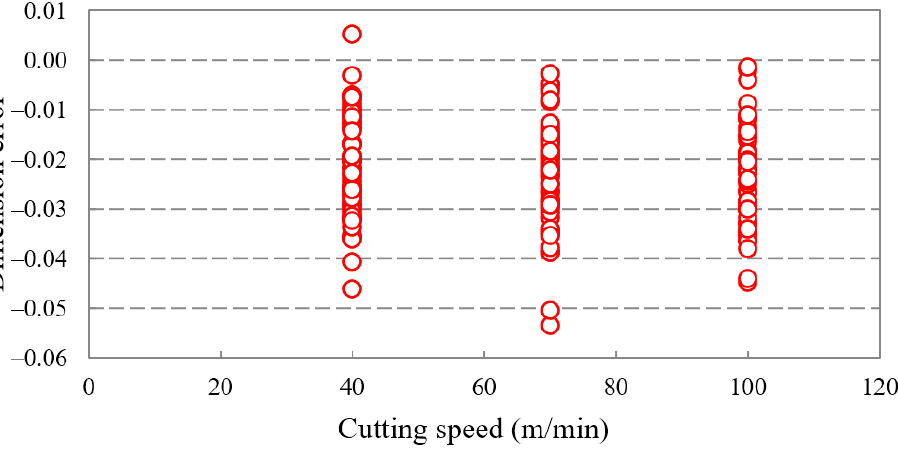
Figure 20. Distribution graph of dimensional accuracy in terms of axial depth of cut.